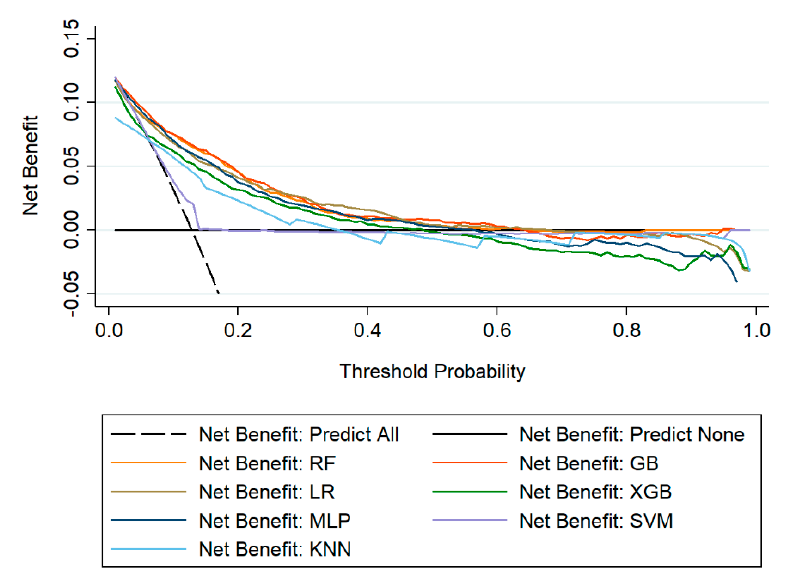
Figure 4. Decision curve analysis of machine learning models for prediction of HAT in the test set.